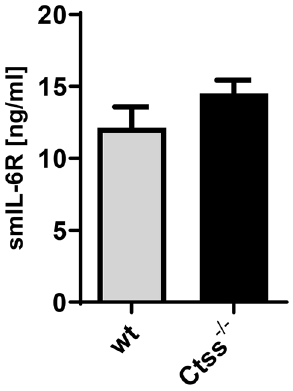
Figure 6. Cathepsin S does not contribute to constitutive sIL-6R generation in vivo. Levels of sIL-6R were determined via ELISA in serum samples from three wild-type and three Ctss −/− mice (mean ±